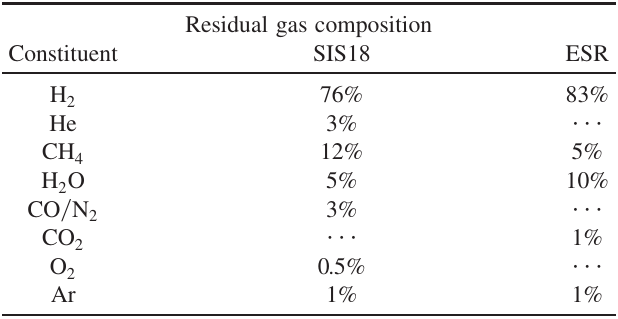
TABLE II. Estimated residual gas composition in the SIS18 synchrotron and the ESR storage ring. The values should be considered as a rough estimate. Deviations from 100% are due to round-off